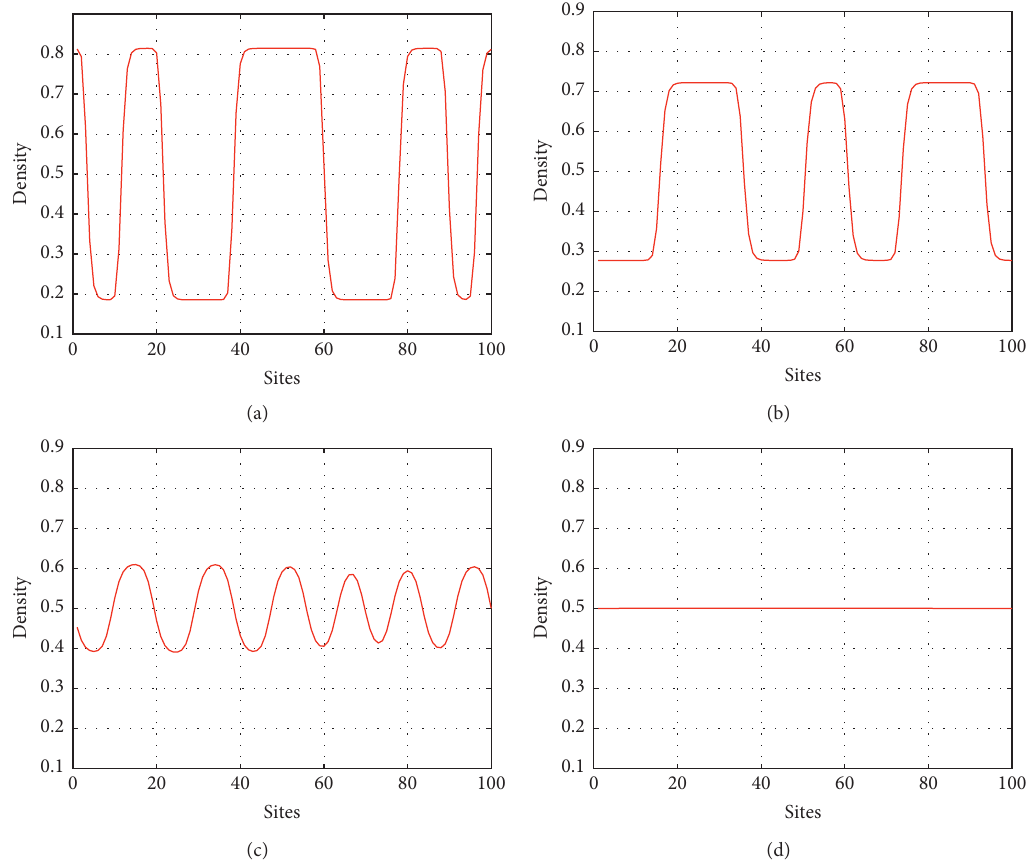
Figure 6: Density profile of the density wave at t � 10300 s corresponds to Figure 5. (a) λ � 0, (b) λ � 0.1, (c) λ � 0.2, (d) λ � 0.3.